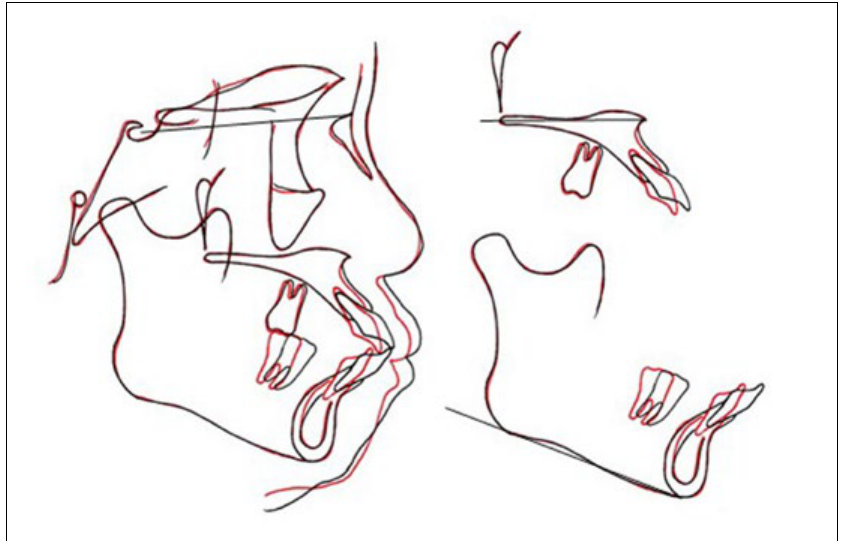
Figure 8. Superimposed lateral cephalometric tracings: pretreatment, black line; post-treatment, red